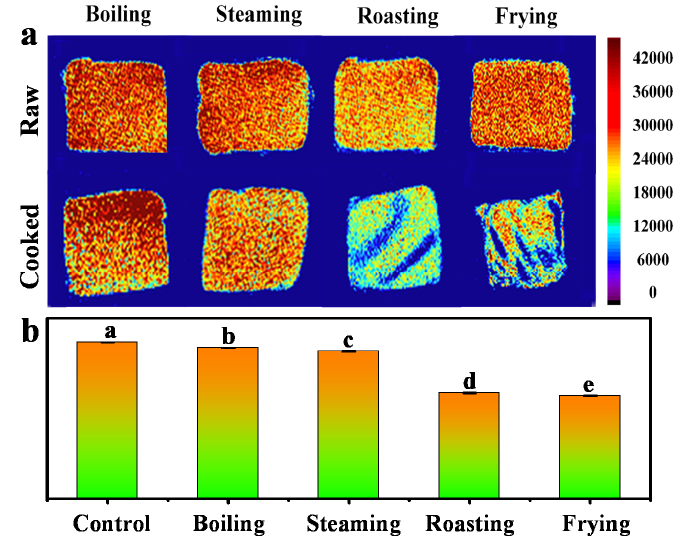
Figure 2. ( a ) T 1 weighted magnetic resonance images of fish samples subjected to different cooking methods, ( b ) the corresponding histogram of quantitative signal intensity. Control is sample without heating treatment. Different letters indicate significant differences between groups ( p < 0.05).